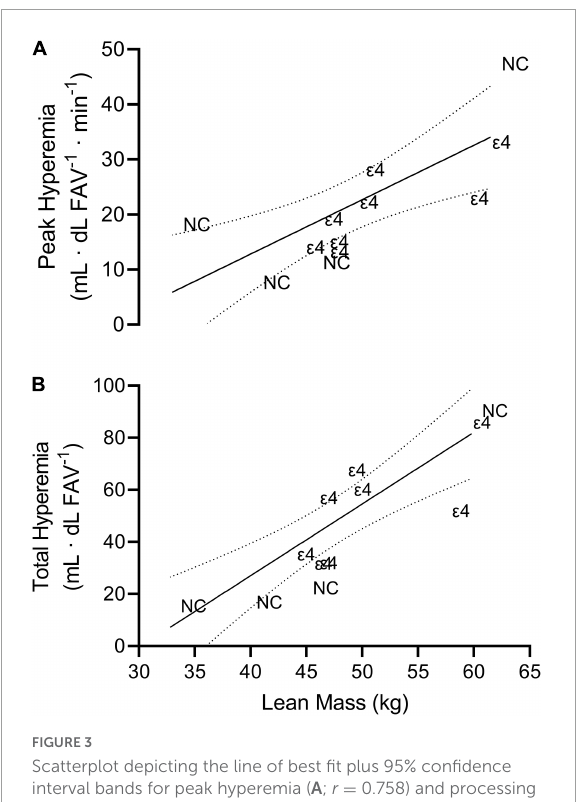
FIGURE2 Scatterplot depicting the line of best fit plus 95% confidence interval bands for complex attention ( A ; r = 0.629) and processing speed ( B ; r = 0.734) vs. brain derived neurotropic factor (BDNF). Each individual data point is presented as either ε 4 or NC indicating which data correspond to individuals with apolipoprotein ε 4 carriage and non-carriers, respectively.